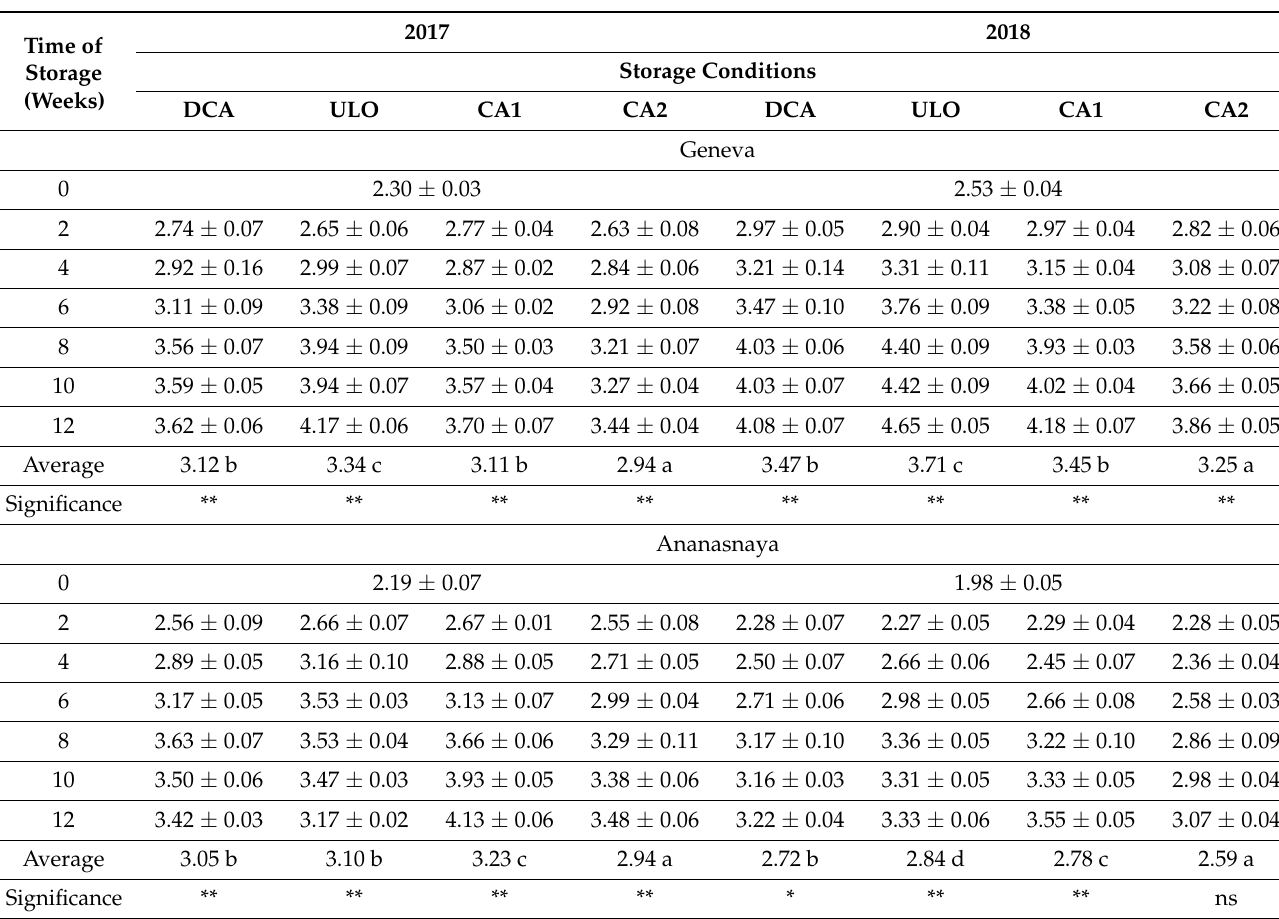
carbon dioxide caused a decrease in the value of the L index, which substantiates the darkening of the skin color. Table 5. Changes in fructose contents (g · 100 g − 1 F.W.) measured in ‘Geneva’ and ‘Ananasnaya’ minikiwi fruits in the postharvest period.